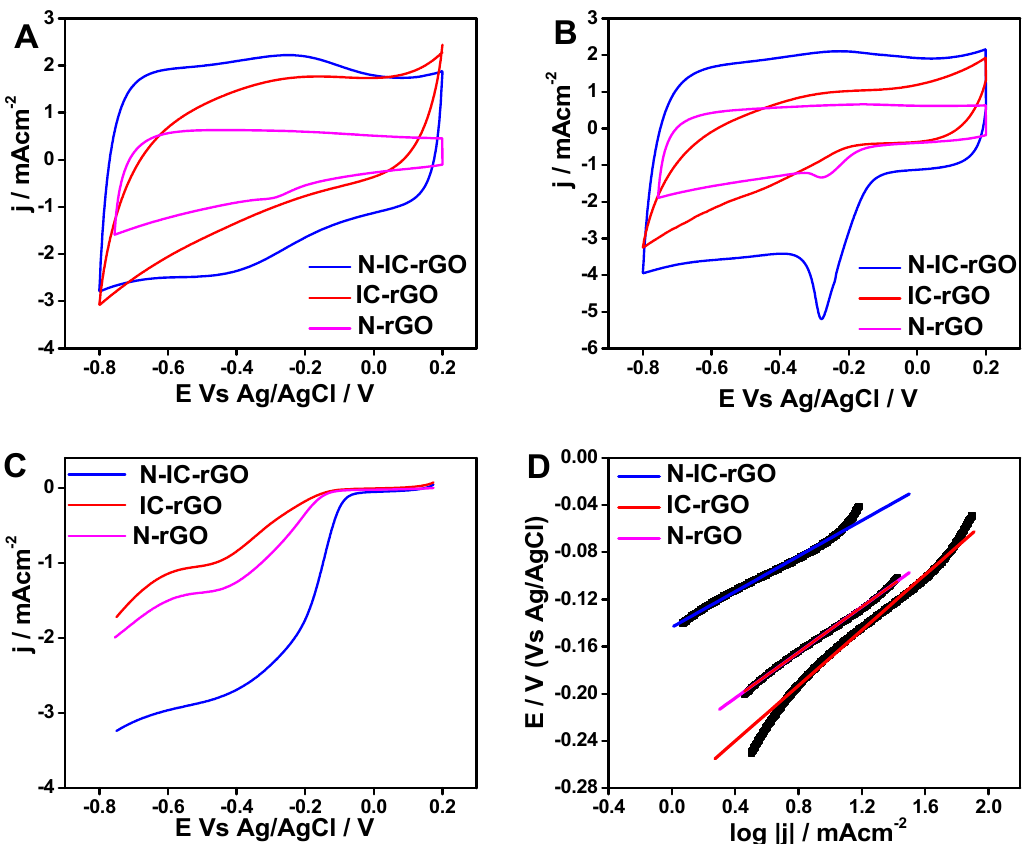
Figure 7. Cyclic voltammogram conducted in 0.1 M KOH at a scan rate of 50 mV s − 1 for IC-rGO, N-IC-rGO, and N-rGO modified glassy carbon electrodes in ( A ) argon-saturated and ( B ) oxygen-saturated environments. ( C ) Linear sweep voltammogram performed in 0.1M KOH with 2.0 mV s − 1 for IC-rGO, N-IC-rGO and N-rGO. ( D ) Tafel plots constructed from linear sweep voltammogram (LSV) data for IC-rGO, N-IC-rGO, and N-rGO.